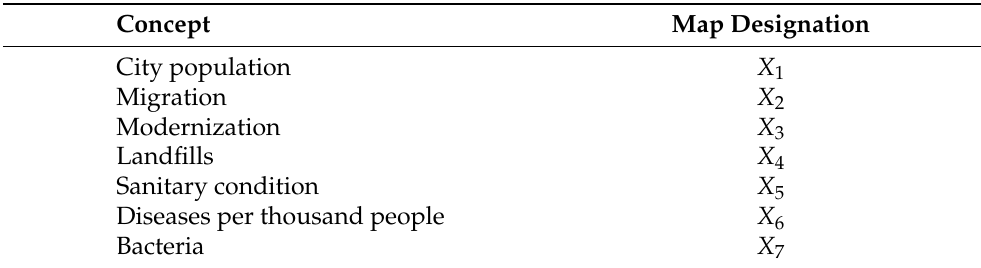
Figure 4. The fuzzy cognitive map of the system presenting the ecological state of the city. Table 3. Concepts of the fuzzy cognitive map determining the ecological situation in the